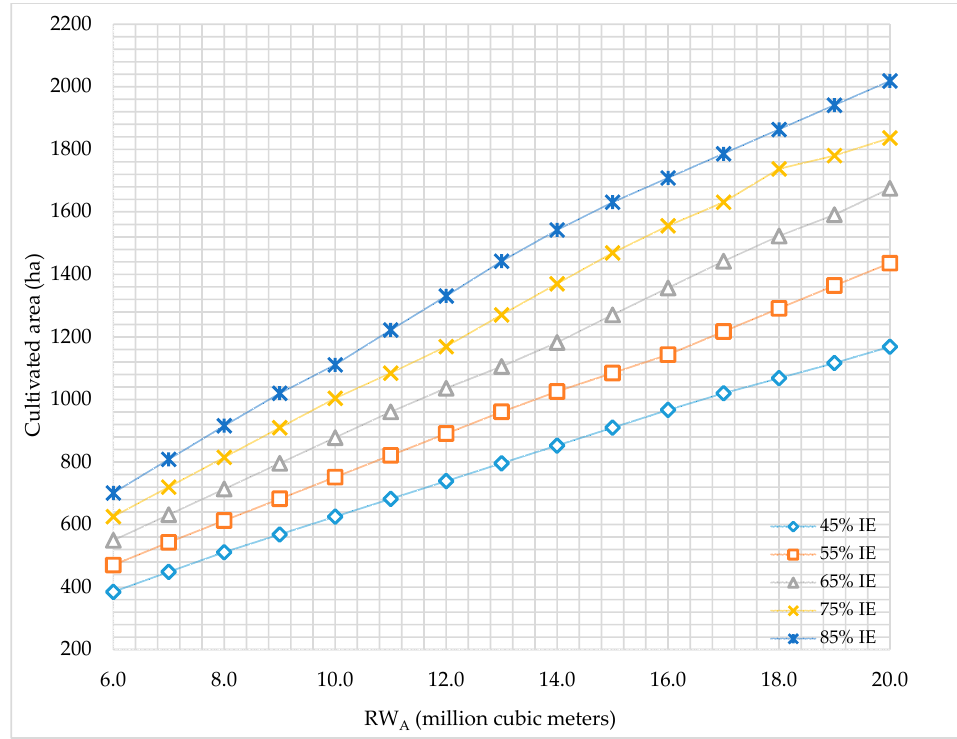
Figure 4. Total cultivated area (ha) predicted using reclaimed water type A (RW A ) with five different irrigation efficiencies (IEs). Water 2018 , 7 , x FOR PEER REVIEW